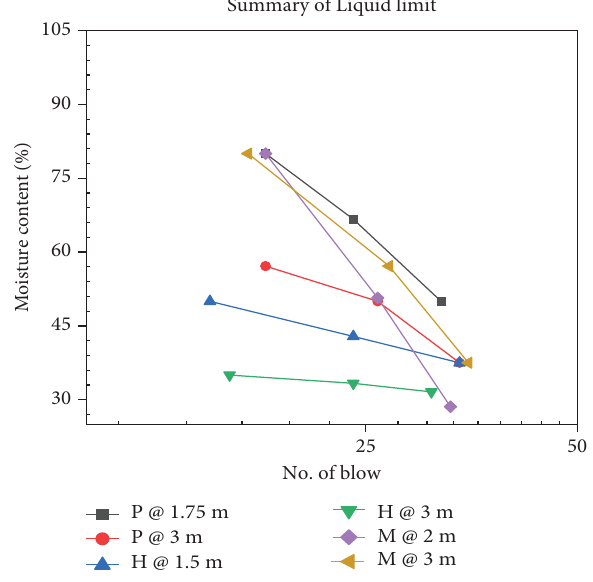
Figure 5: Summary of liquid limit curves.